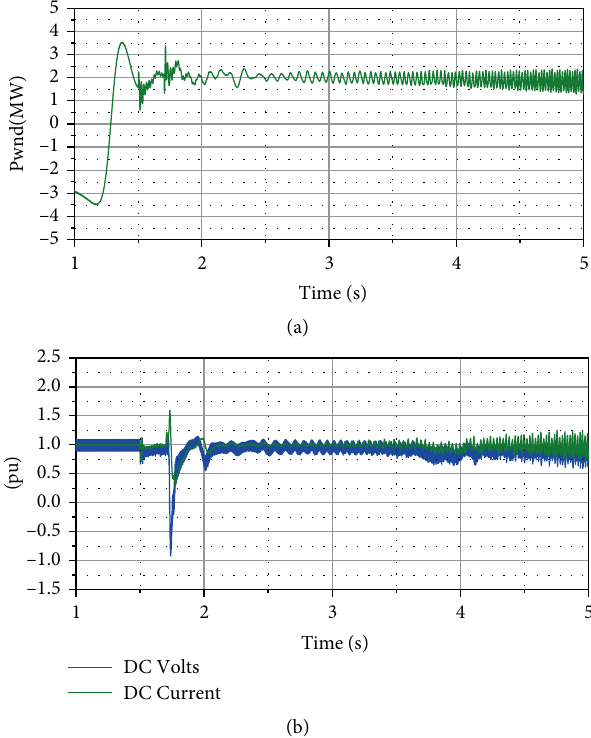
Figure 5: Effect of SSR in the grid. (a) Power flow in one of the wind farm turbines. (b) DC voltage and current responses in the HVDC.